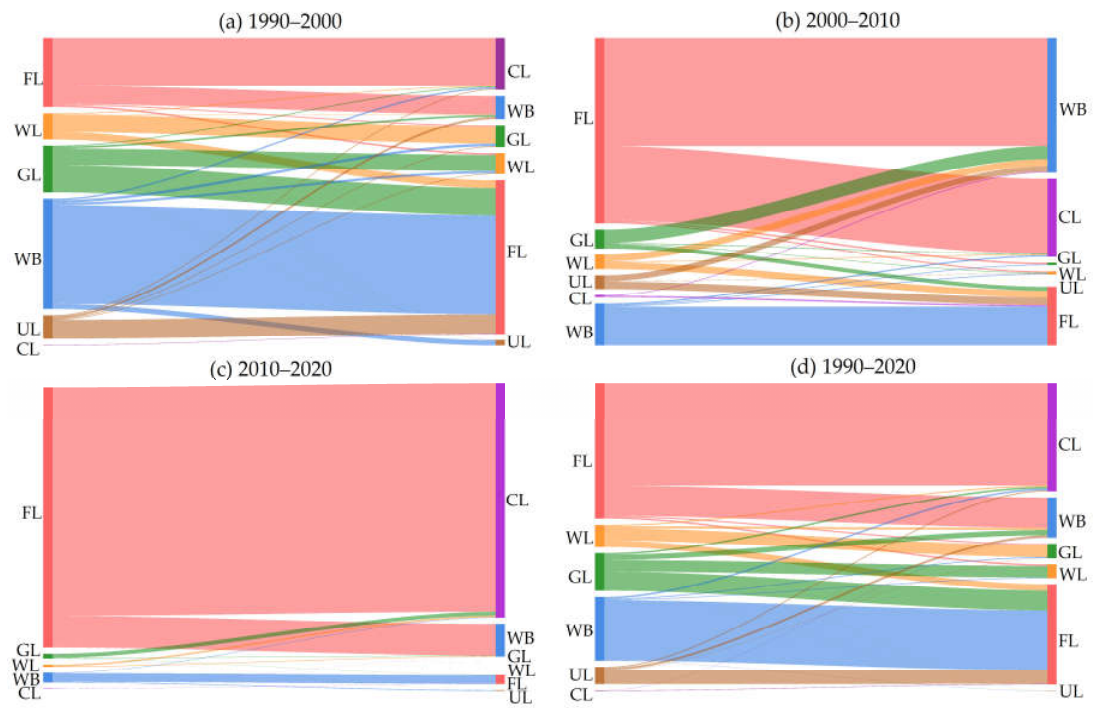
Figure 3. Quantitative change trajectories of land use types in the Yellow River Basin (Henan section): ( a ) trajectory map for 1990–2000; ( b ) trajectory map for 2000–2010; ( c ) trajectory map for 2010–2020; ( d ) trajectory map for 1990–2020. Note: FL, WL, GL, WB, CL and UL represent farmland, woodland, grassland, water, construction land and unused land, respectively. The trajectory lines of different colors represent the flow direction of the corresponding class in a specific period, and the thickness of the lines represents the amount of land conversion. The thicker the lines, the greater the amount of